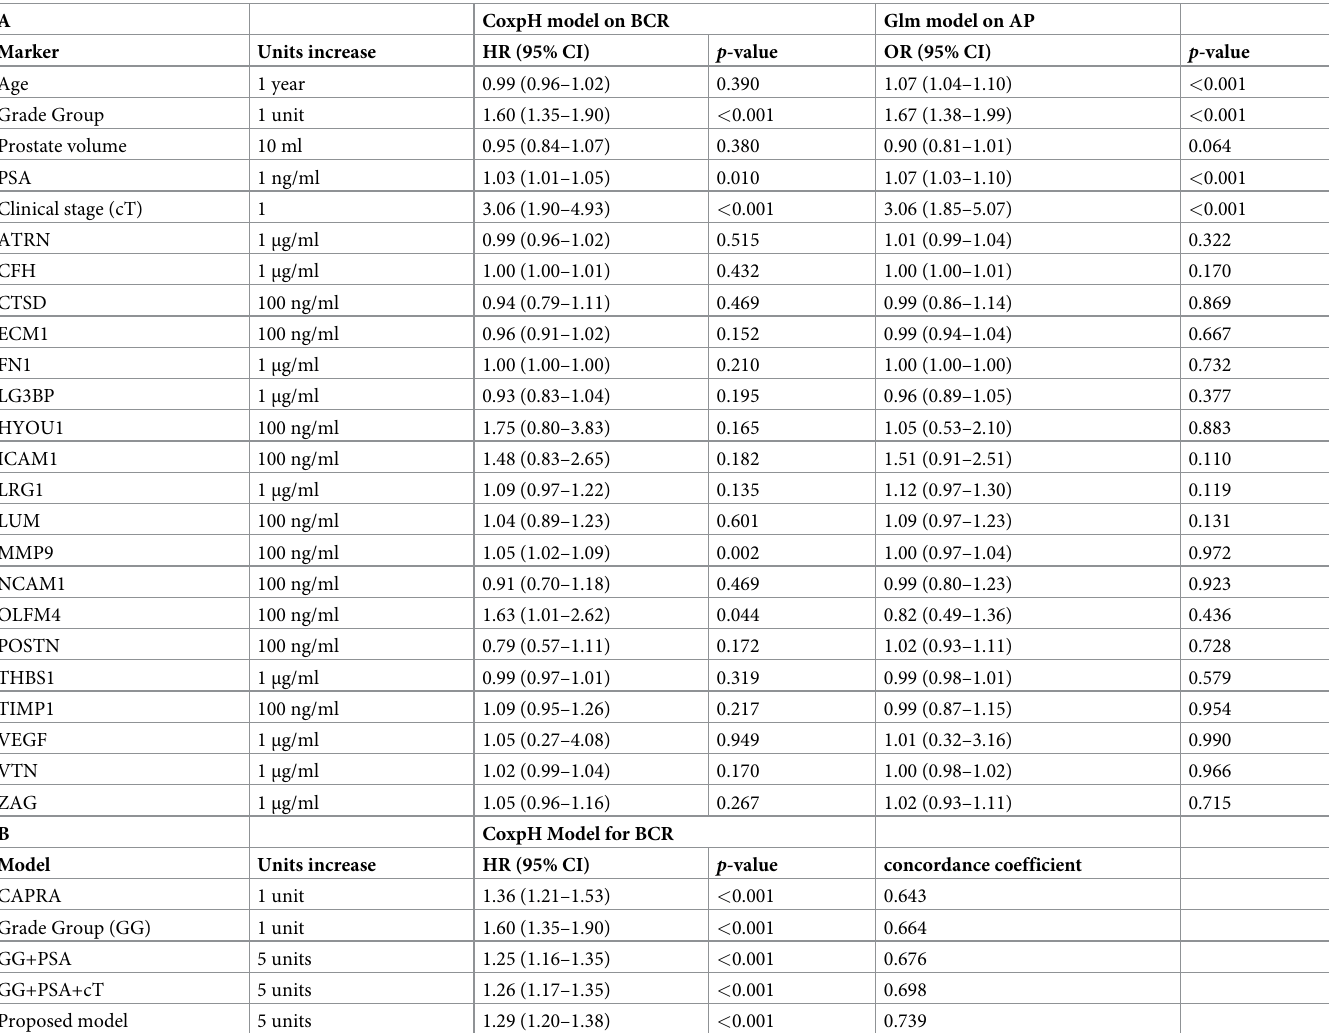
Table 2. Uni- and multivariate analysis. (A) Univariate hazard ratio of Cox proportional hazards regression (CoxPH) on Biochemical recurrence after surgery (BCR) and odd ratios of General Linear Model (Glm) on adverse pathology (AP). (B) Multivariate CoxpH on BCR, the proposed model is composed of Grade Group + PSA + cT + LUM + FN1 + LG3BP + MMP9